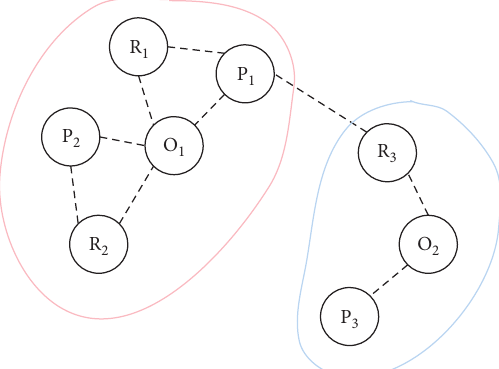
Figure 2: An exemplary snapshot ( G t ) of a multimodal organizational network consisting of people P , resources R , and other intangible assets. All nodes belonging to an organization have links to a corresponding organizational node O . The relations translate to organizational boundaries (delineated with colored circles). Source: own